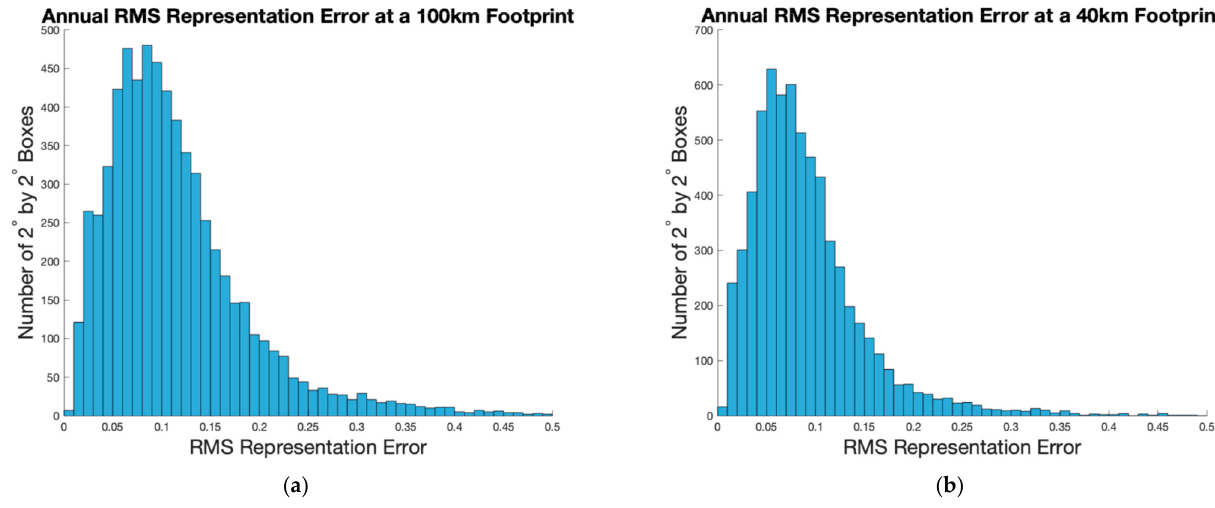
Figure 9. As in Figure 2c,d, but for RMS RE instead of SFV. ( a , b ) Display the same RMS RE values as histograms, which count the number of 2° × 2° boxes with the given RMS RE for the full year. The total number of boxes in both figures is 10,440. Note different y -axis limits in the two panels.